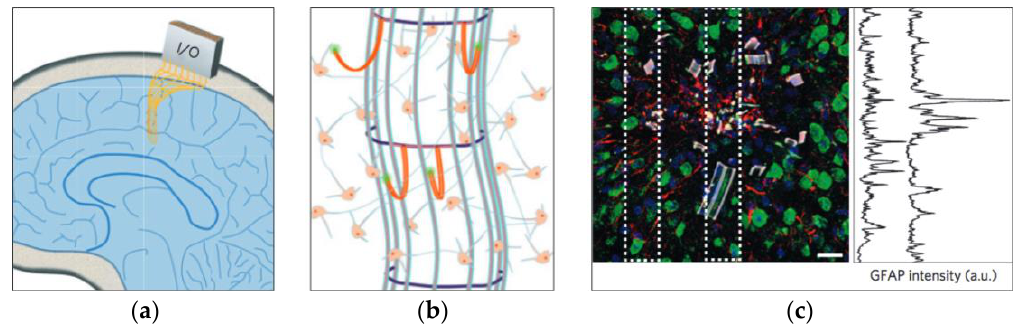
Figure 4. 3D macroporous brain probes reprinted with permission from Xie et al. Schematics of ( a ) insertion scheme and ( b ) 3D spherical structure with flexible arms that are designed to protrude through the glial scar and form a close contact to the neurons; and ( c ) immunohistochemistry (IHC) of the insertion site demonstrating an extremely low immune response with a high neuronal density [85].